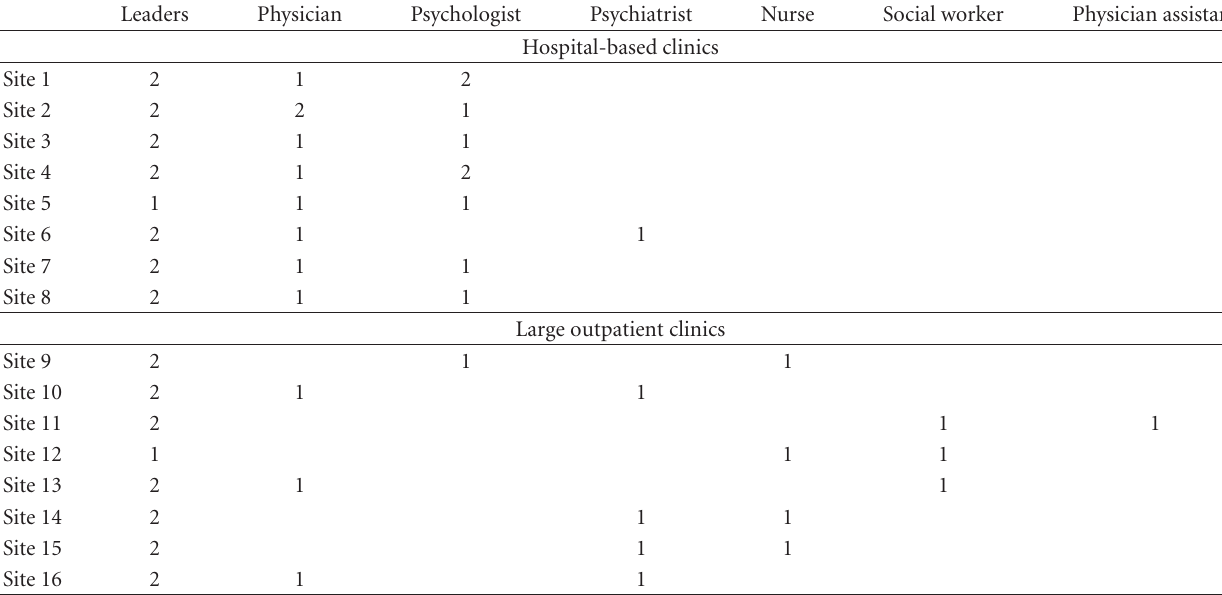
Table 2: Sampling of key informants across the sixteen